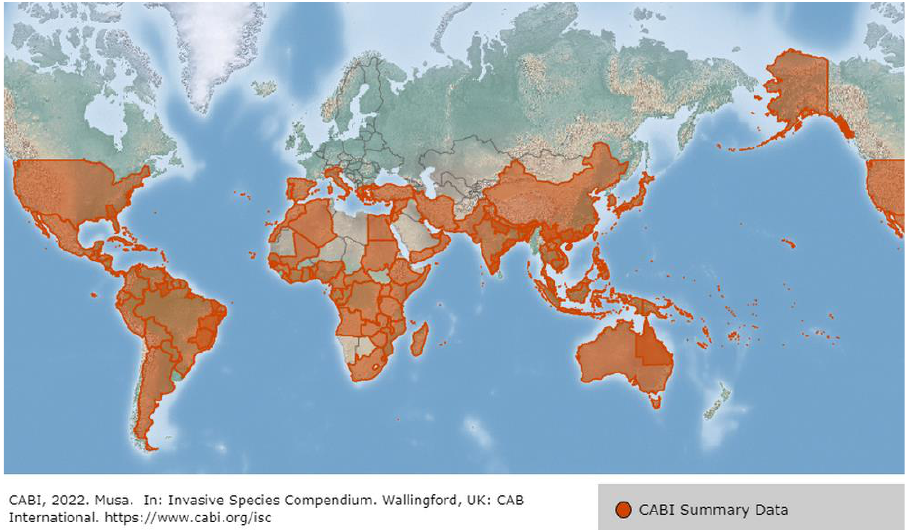
Figure 1. Global distribution of banana ( Musa spp.) species is indicated by the orange color intensity. Map generated using Centre for Agriculture and Bioscience International (CABI), (https://www.cabi.org/isc/datasheet/35124#toDistributionMaps accessed on 22 December 2022).